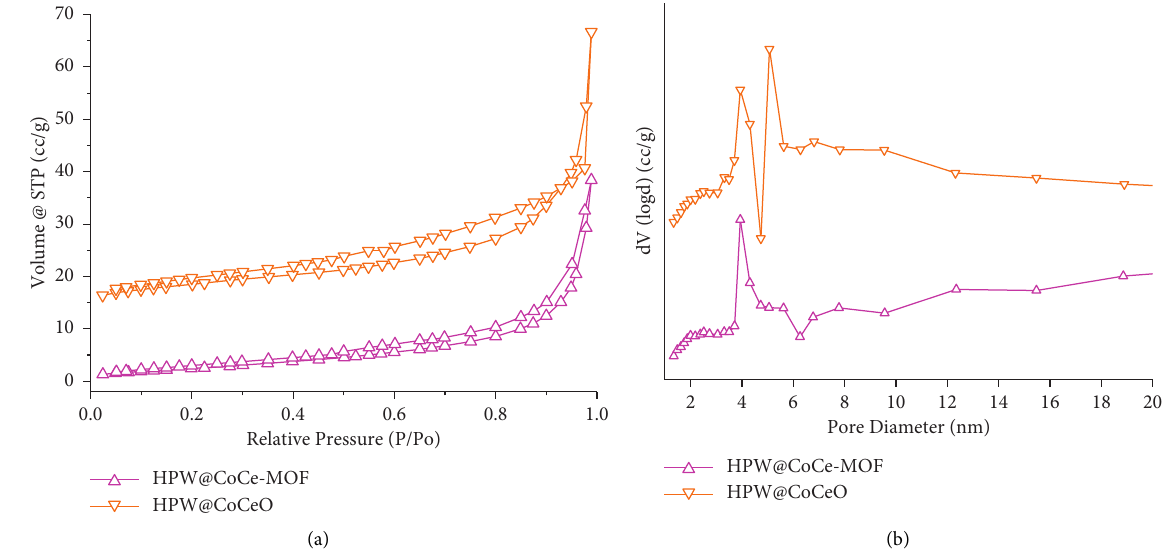
Figure 4: (a) Profiles of N 2 adsorption-desorption patterns and (b) BJH pore size distribution of HPW@CoCe-MOF and HPW@CoCeO composites.